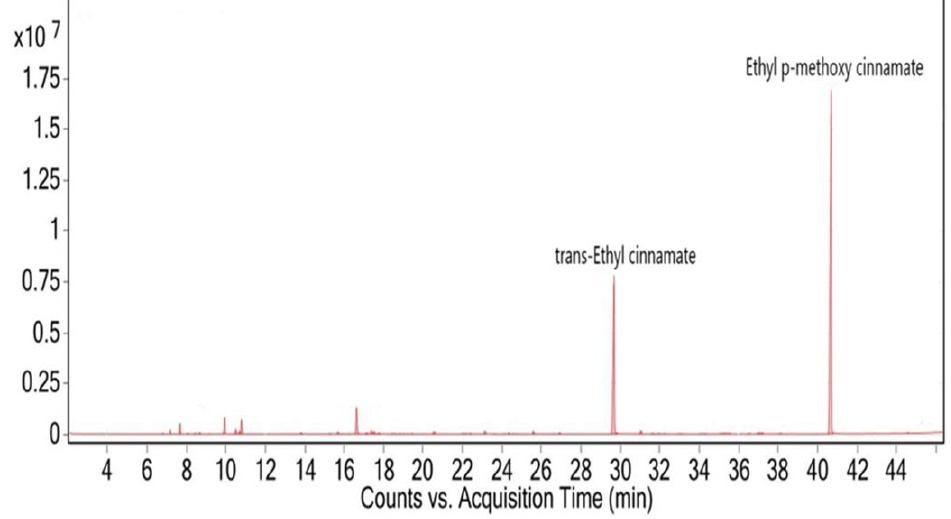
Figure 8. GC/MS chromatogram of Bharamputra-1 essential oil.